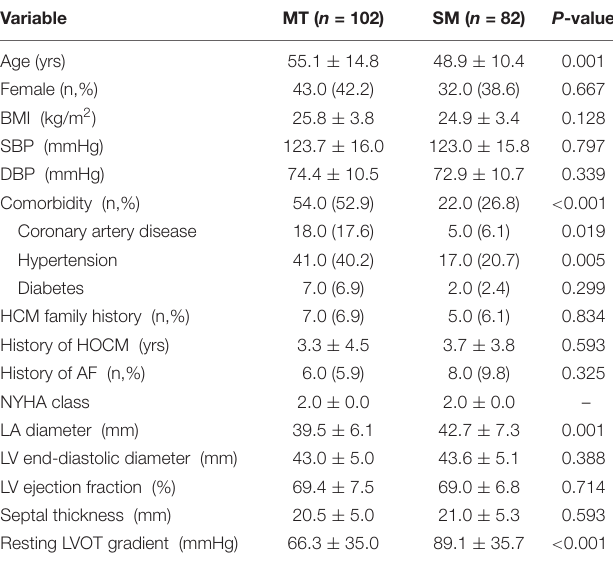
TABLE 1 | Characteristics of 184 mildly symptomatic patients with HOCM at baseline.